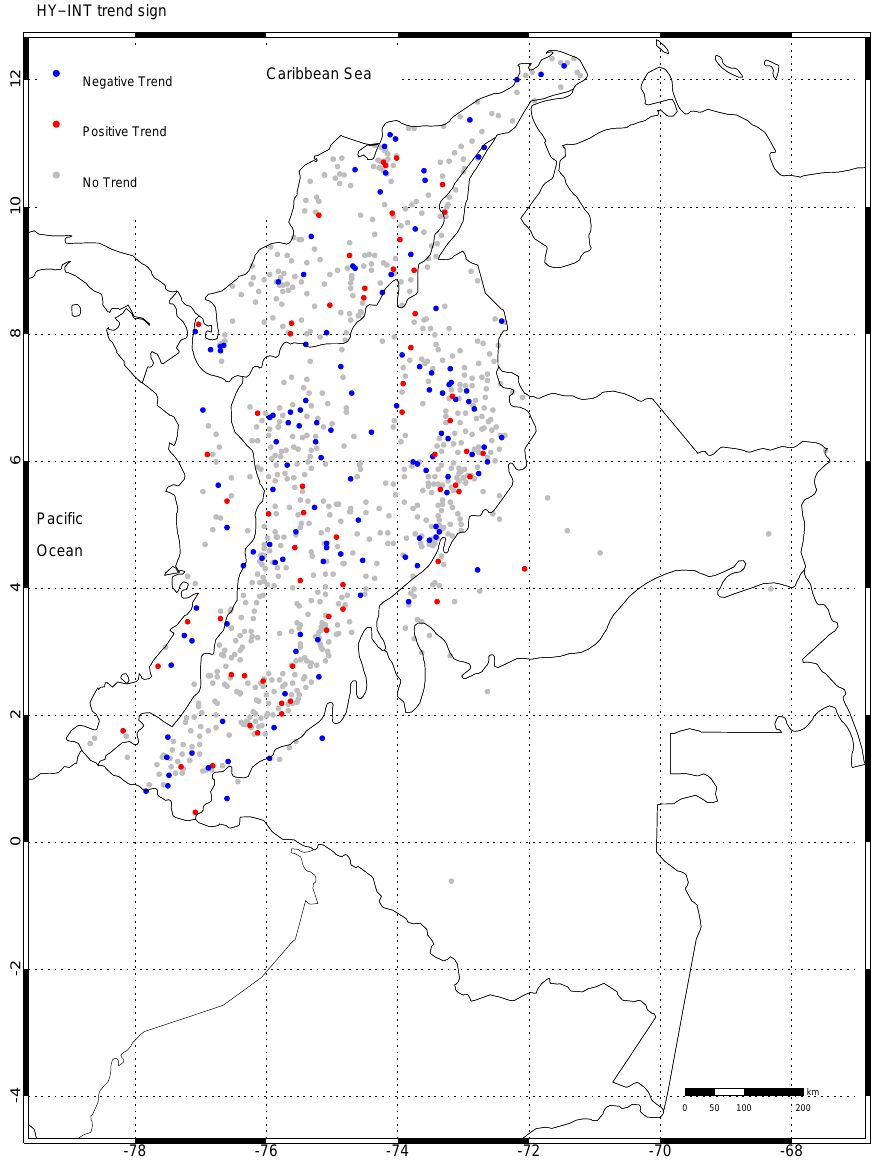
Figure 2. Map of the trend sign for HY-INT for rain gauge base dataset. Non-significant trends are plotted in